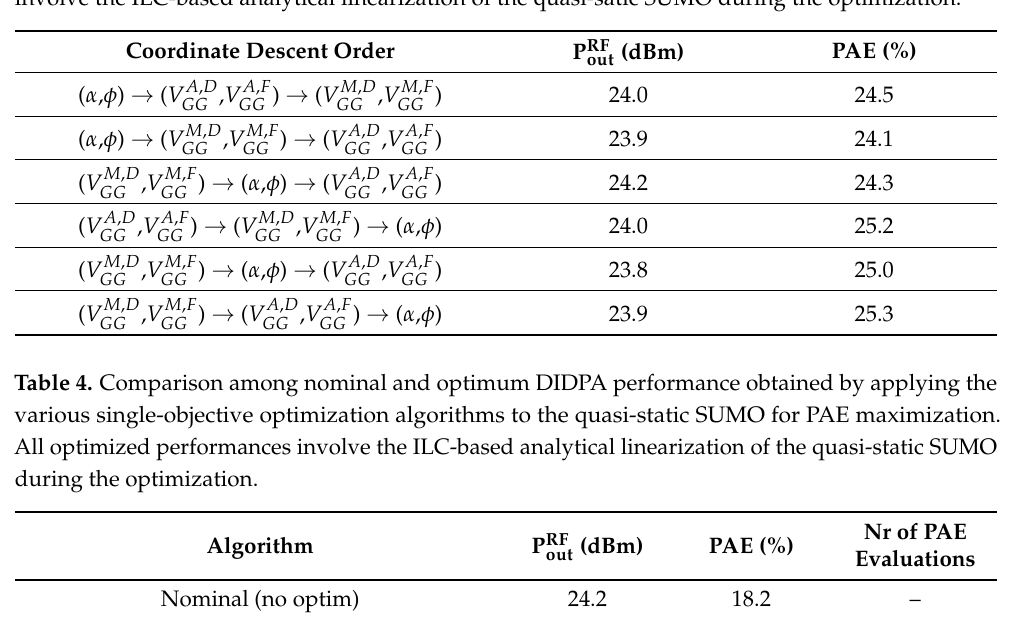
Table 3. Comparison among optimum DIDPA performance obtained by applying the coordinate descent algorithm to the quasi-static SUMO for PAE maximization. All optimized performances involve the ILC-based analytical linearization of the quasi-satic SUMO during the optimization.